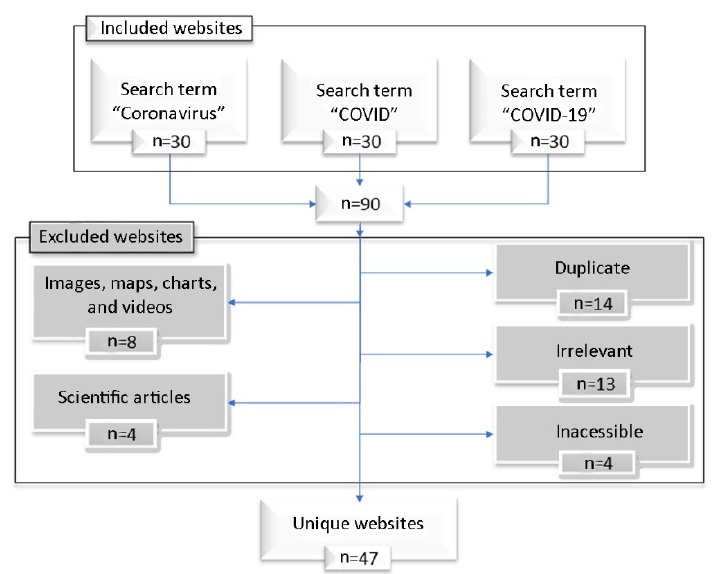
Figure 1 Google search flow diagram for website